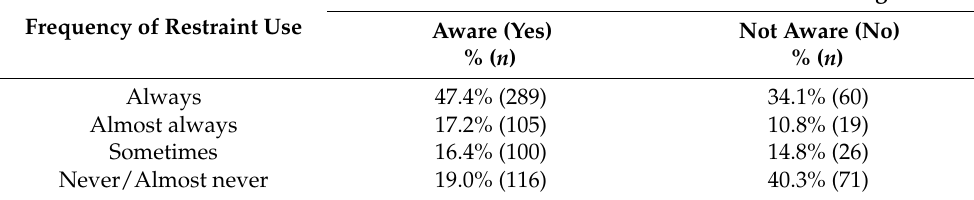
Table 8. Participant’s awareness of the upcoming introduction of CRS and booster seat legislation and frequency of restraint use for their eldest child while travelling in a motor vehicle.